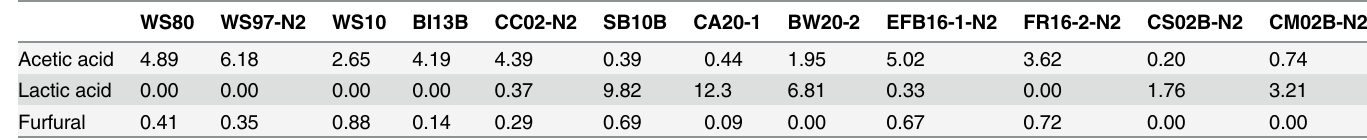
Table 3. Concentration of acetic acid, lactic acid and furfural in the final and most concentrated influents applied to the fermentations (g/L).